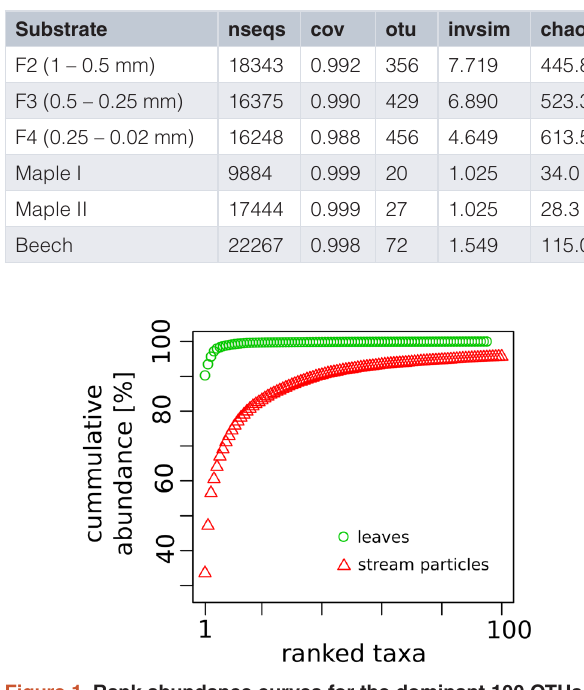
Figure 1. Rank abundance curves for the dominant 100 OTUs of leaves and stream particles, all leaf samples (beech and maple samples) and all size fractions were combined into the two categories “leaves” and “stream particles” (based on Dataset 3).